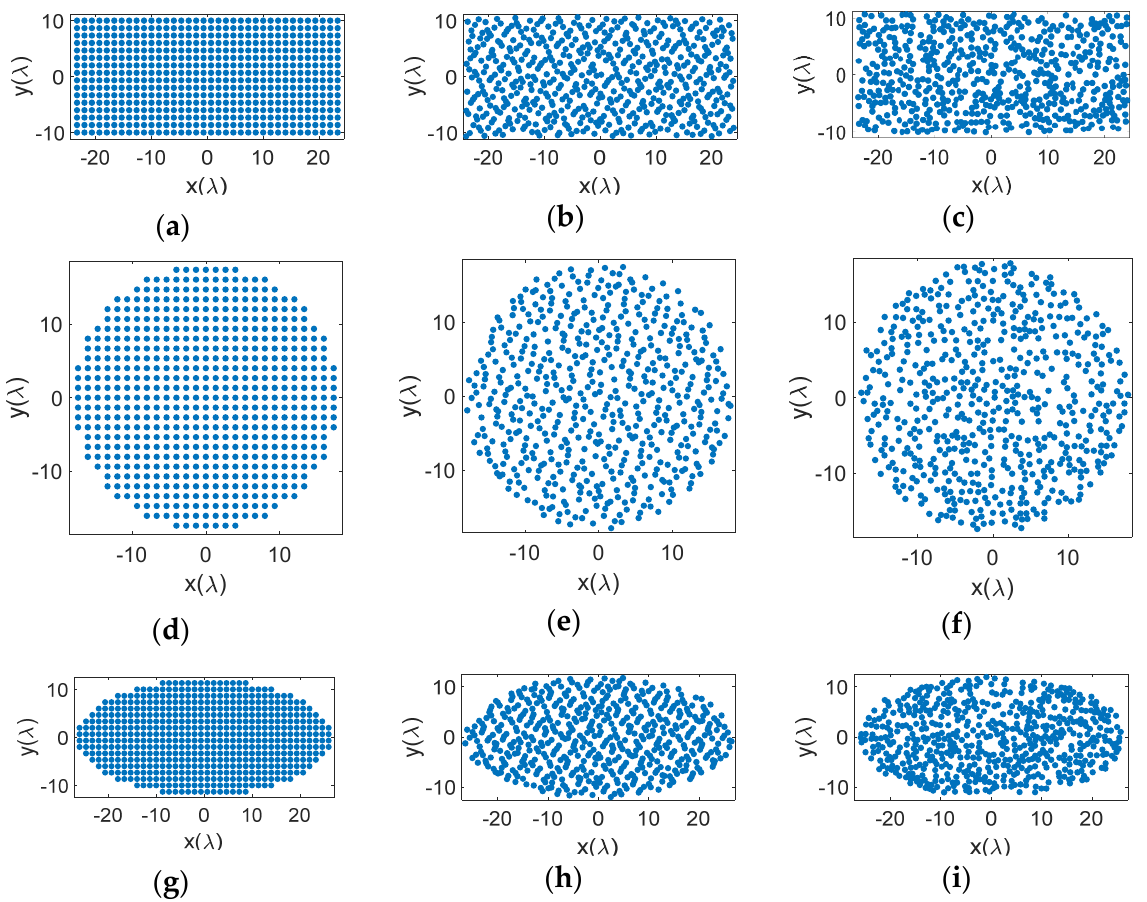
Figure 6. Position of elements on rectangular, circular, and elliptical apertures with different distributions: ( a ) uniform (rectangular), ( b ) Halton (rectangular), ( c ) Poisson disk (rectangular), ( d ) uniform (circular), ( e ) Halton (circular), ( f ) Poisson disk (circular), ( g ) uniform (elliptical), ( h ) Halton (elliptical), ( i ) Poisson disk (elliptical).